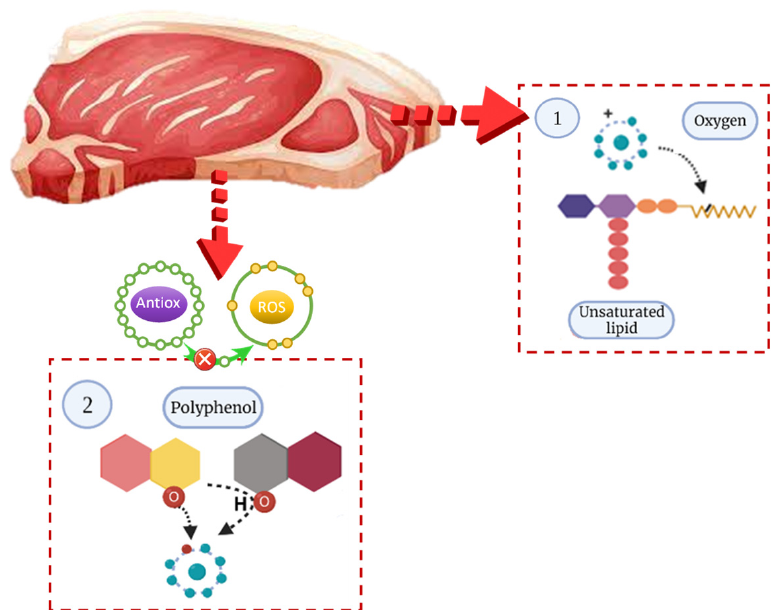
Figure 3. Antioxidant mechanisms of polyphenols. ( 1 ) Oxygen or reactive oxygen species, deficient in electrons, react with the double bonds of the carbon chains of fatty acids. ( 2 ) Polyphenol molecule transfers an electron or a proton to the reactive oxygen species, stabilizing it and preventing it from reacting with the fatty acids (created with BioRender.com, 3 July 2021).